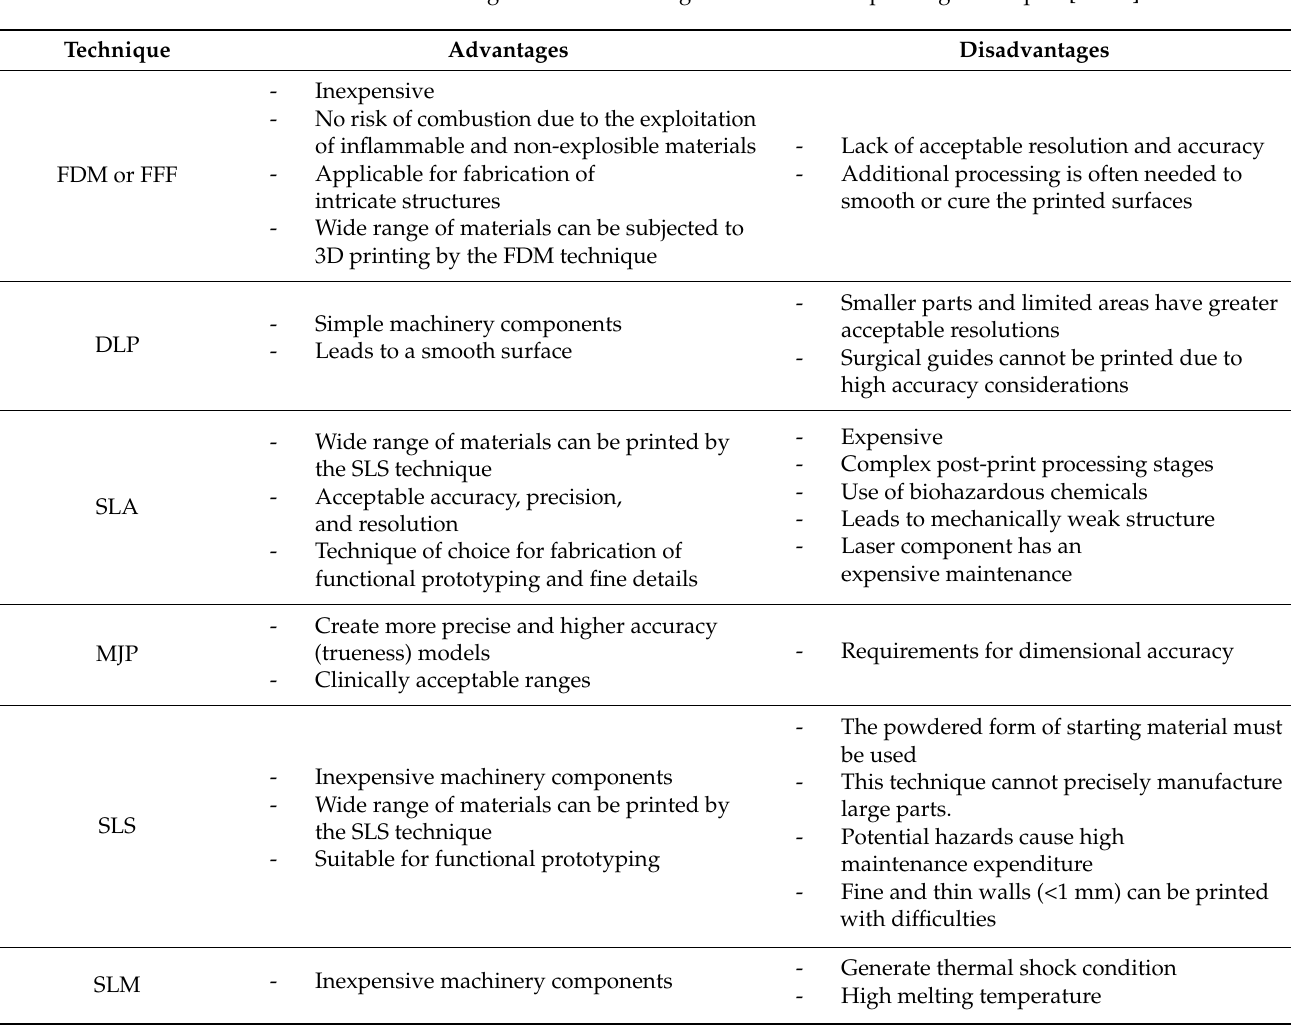
Table 1. Advantages and disadvantages of common 3D printing techniques